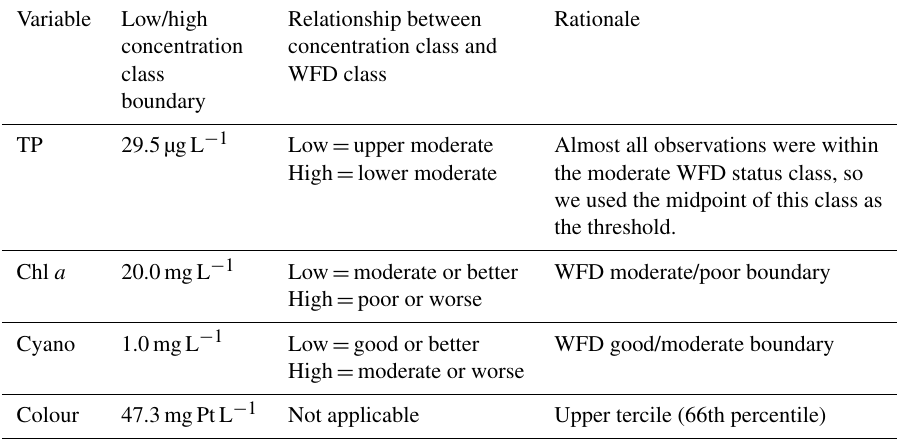
Not applicable Upper tercile (66th